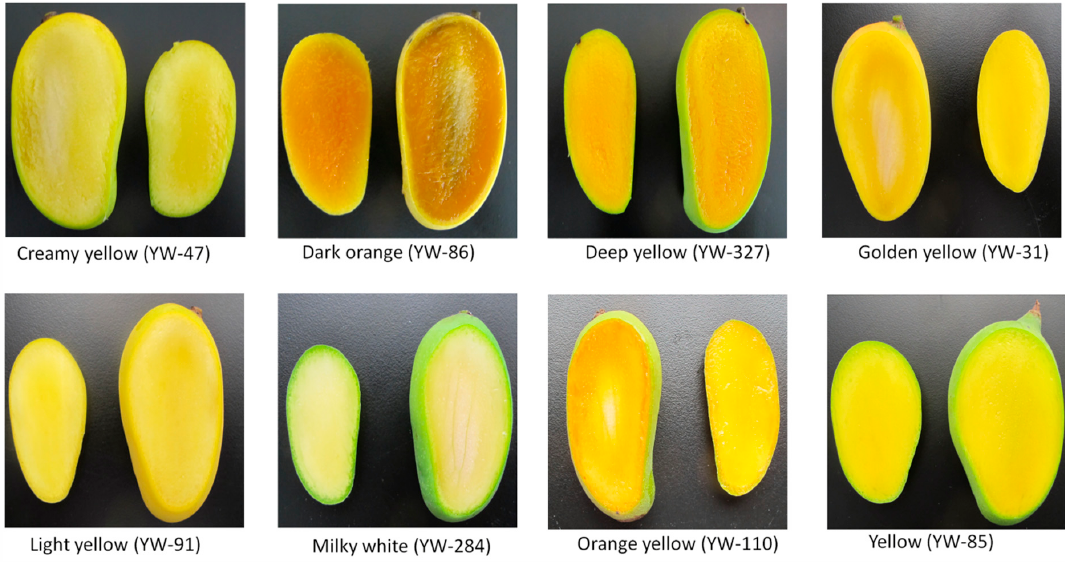
Figure 3. Diversity of color of the fruit flesh within the mango germplasm. Accession name is in brackets.